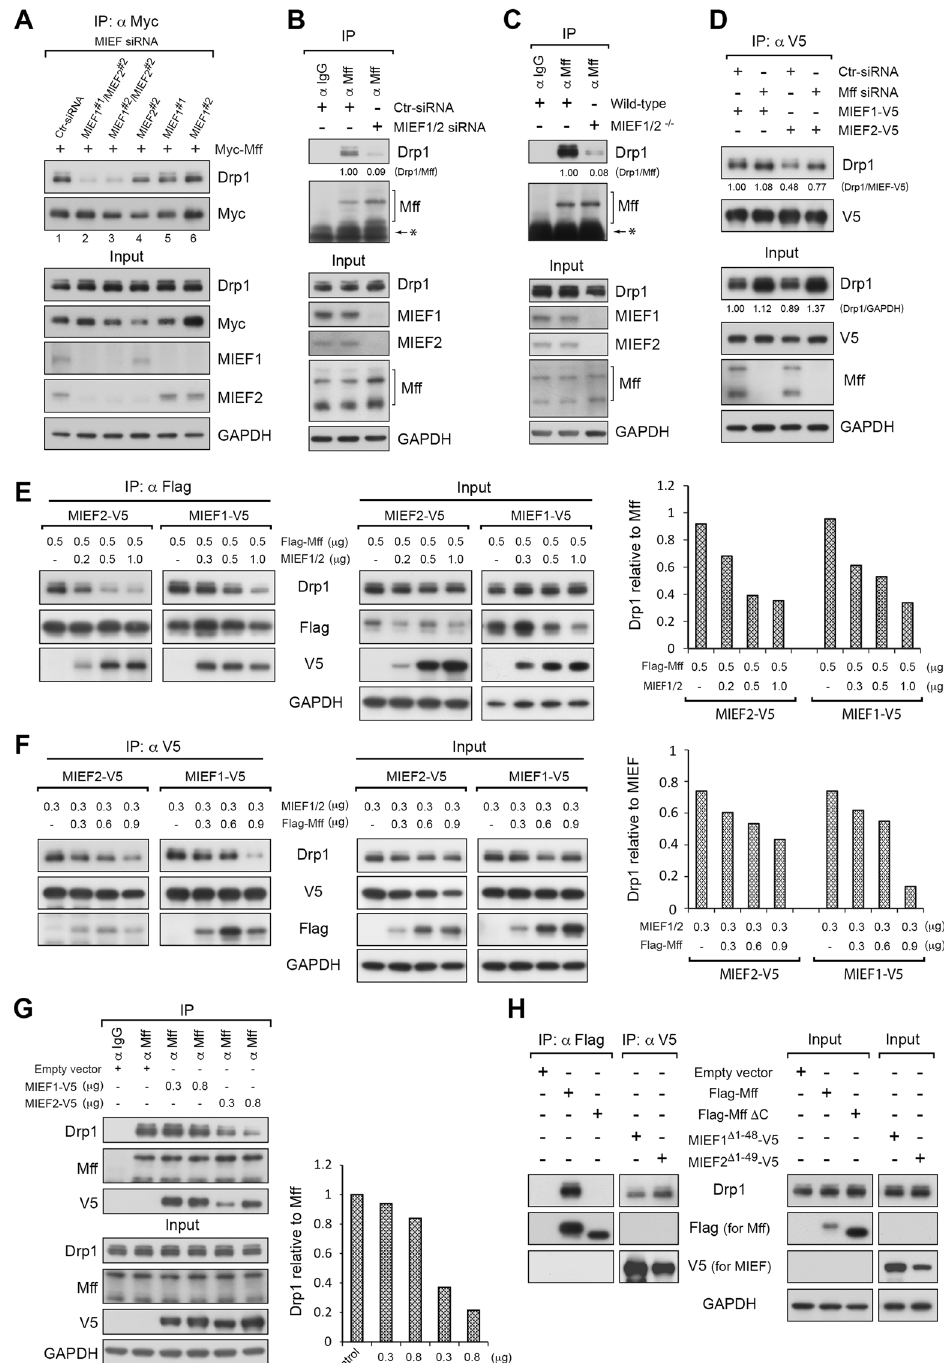
Figure 4. Depletion of MIEF1/2 largely reduces Mff-Drp1 interaction and the binding preference of Drp1 to MIEFs versus Mff depends on the relative amounts of MIEFs and Mff. ( A ) Knockdown of MIEF1/2 severely reduced the binding of exogenous Mff to Drp1. 293T cells were treated with control, MIEF1 or MIEF2 siRNA alone, or MIEF1 plus MIEF2 siRNAs in two different combinations, and then transfected with Myc-Mff. Cell lysates were used for co-IP with anti-Myc beads. ( B ) Knockdown of MIEF1/2 severely reduced the endogenous interaction between Mff and Drp1. 293T cells were treated with control, or MIEF1 plus MIEF2 siRNAs. Cell lysates were used for co-IP at endogenous levels with goat normal IgG (negative control) or goat anti-Mff antibody. The ratio of co-IPed endogenous Drp1/Mff was analyzed by densitometry. * Represents protein G. ( C ) Knockout of MIEF1/2 severely reduced endogenous interaction of Mff with Drp1. Cell lysates from wild- type or MIEF1/2 DKO 293T cells were used for co-immunoprecipitation (IP) with Protein G beads connected to goat normal IgG (negative control) or goat anti-Mff antibody. The ratio of co-IPed endogenous Drp1/Mff was analyzed by densitometry. * Represents protein G. ( D ) Knockdown of Mff does not impair the